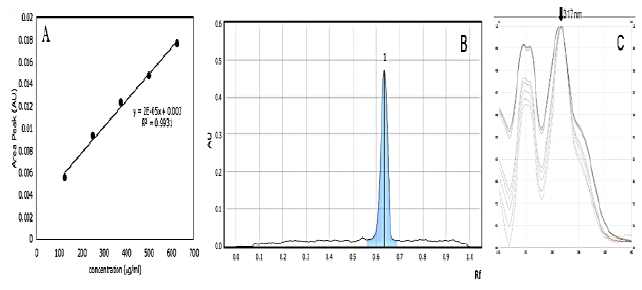
Figure 5: Alpa-mangostin standard calibration curve (A) and densitogram of alpha-mangostin scanned at  = 317 nm (B) and spectrodensitogram of alpha-mangosteen scanned at  range form 200- 700 nm (C).